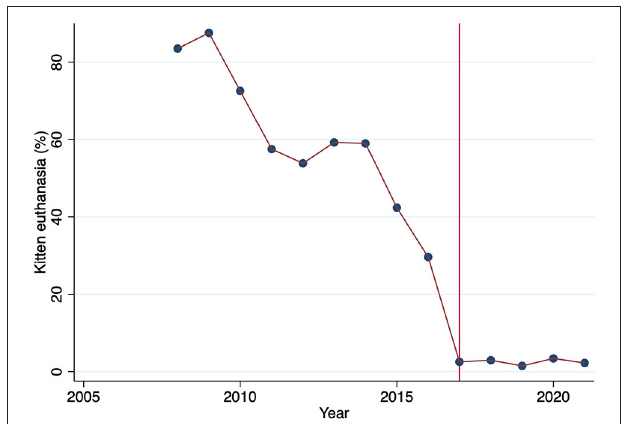
FIGURE 4 | Return to owner rate by year for cats (blue diamond) and dogs (red dot). Solid line at 2017, the year the community case study began. Short dashed line at the national average dog return to owner rate (22%), and long dashed line at the national average cat return to owner rate